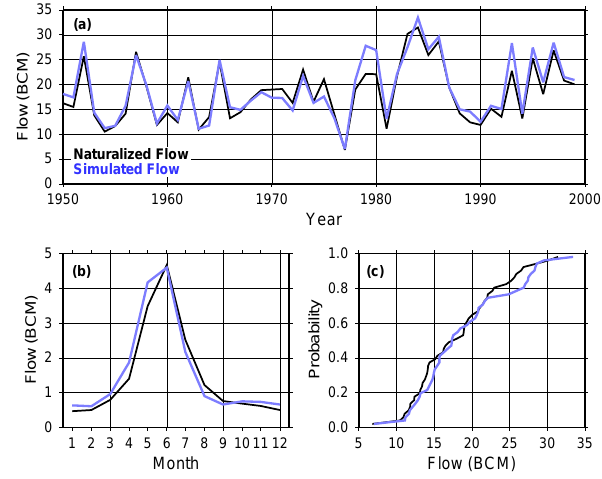
Fig. 2. Comparison of simulated and observed annual stream- flow for the Colorado River at Lees Ferry, AZ. (a) Time series, (b) monthly hydrographs, and (c) ECDFs. BCM is billion (10 9 )m 3 .